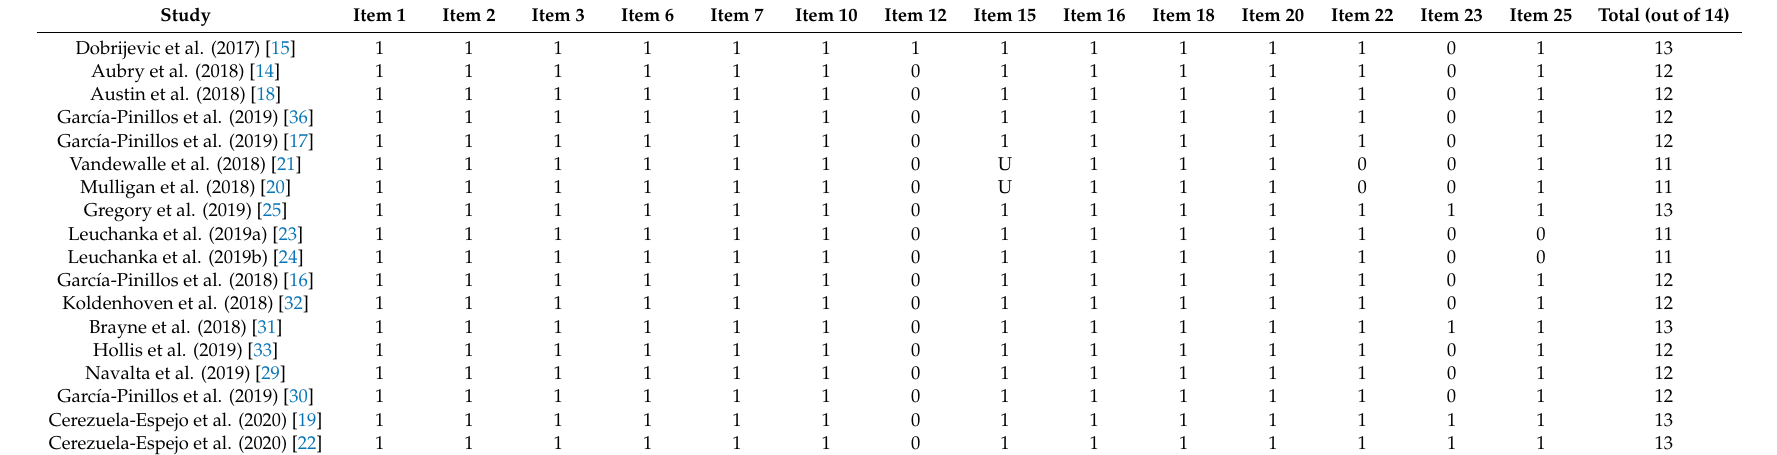
Table 3. Modified Downs and Black scale